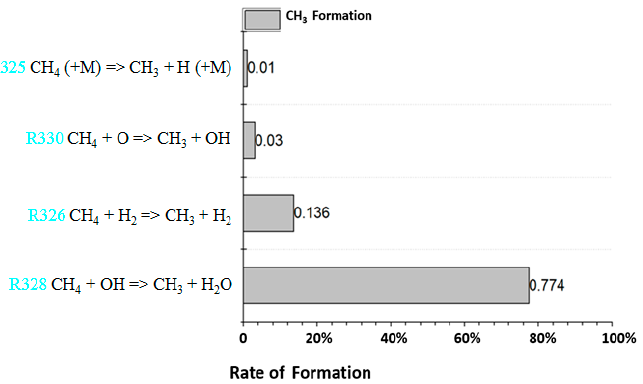
Figure 12. RXR distribution at 353.8 °CA, and the clip plane is along the jet direction axis and ver- tical direction.